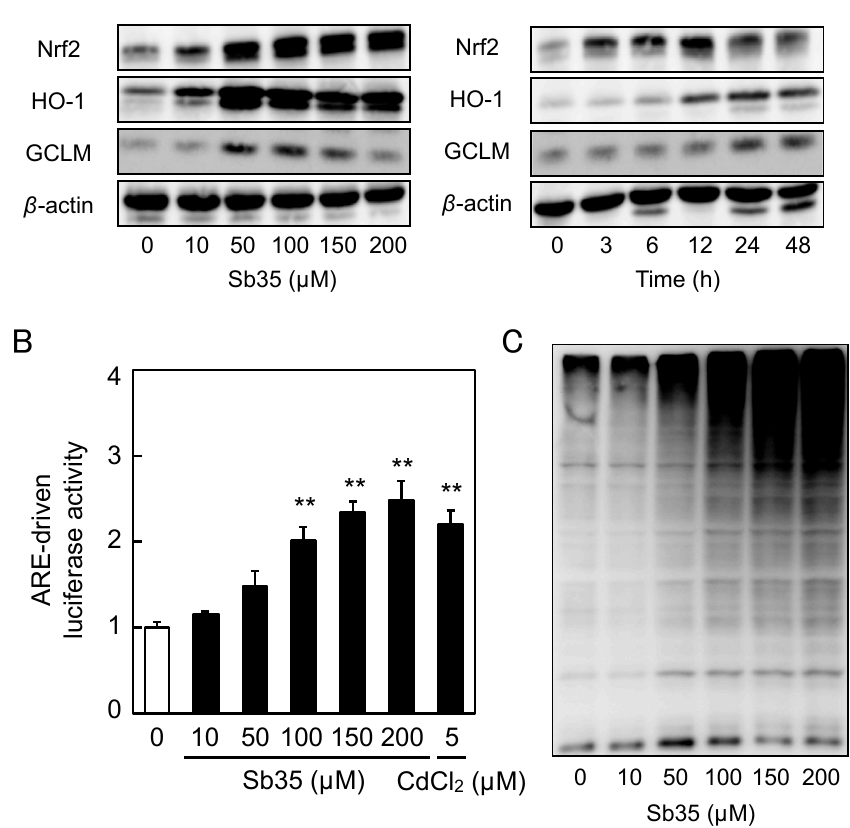
Figure 4. Expression of Nrf2 and its downstream proteins, Sb35-induced ARE-driven transcriptional activity, and Sb35-induced proteasome inhibition in vascular endothelial cells. ( A ) Expression of Nrf2, HO-1, and GCLM. Vascular endothelial cells were treated with or without 10, 50, 100, 150, or 200 µM Sb35 for 12 h ( left panels) or 100 µM Sb35 for 3, 6, 12, 24, or 48 h ( right panels), and expression of Nrf2, HO-1, and GCLM was determined by performing Western blotting; ( B ) ARE-driven transcriptional activity. Vascular endothelial cells transfected with an ARE reporter vector were treated with or without 10, 50, 100, 150, or 200 µM Sb35 or 5 µM cadmium for 12 h, and ARE-driven transcriptional activity was determined by performing ARE-directed reporter assay. Data are represented as mean ± SE of three representative samples, with each sample obtained from three independent experiments. ** p < 0.01 indicates significantly different from the corresponding control; ( C ) Sb35-induced proteasome inhibition. Vascular endothelial cells were treated with or without 10, 50, 100, 150, or 200 µM Sb35 for 24 h, and ubiquitinated proteins were determined by performing Western blotting.